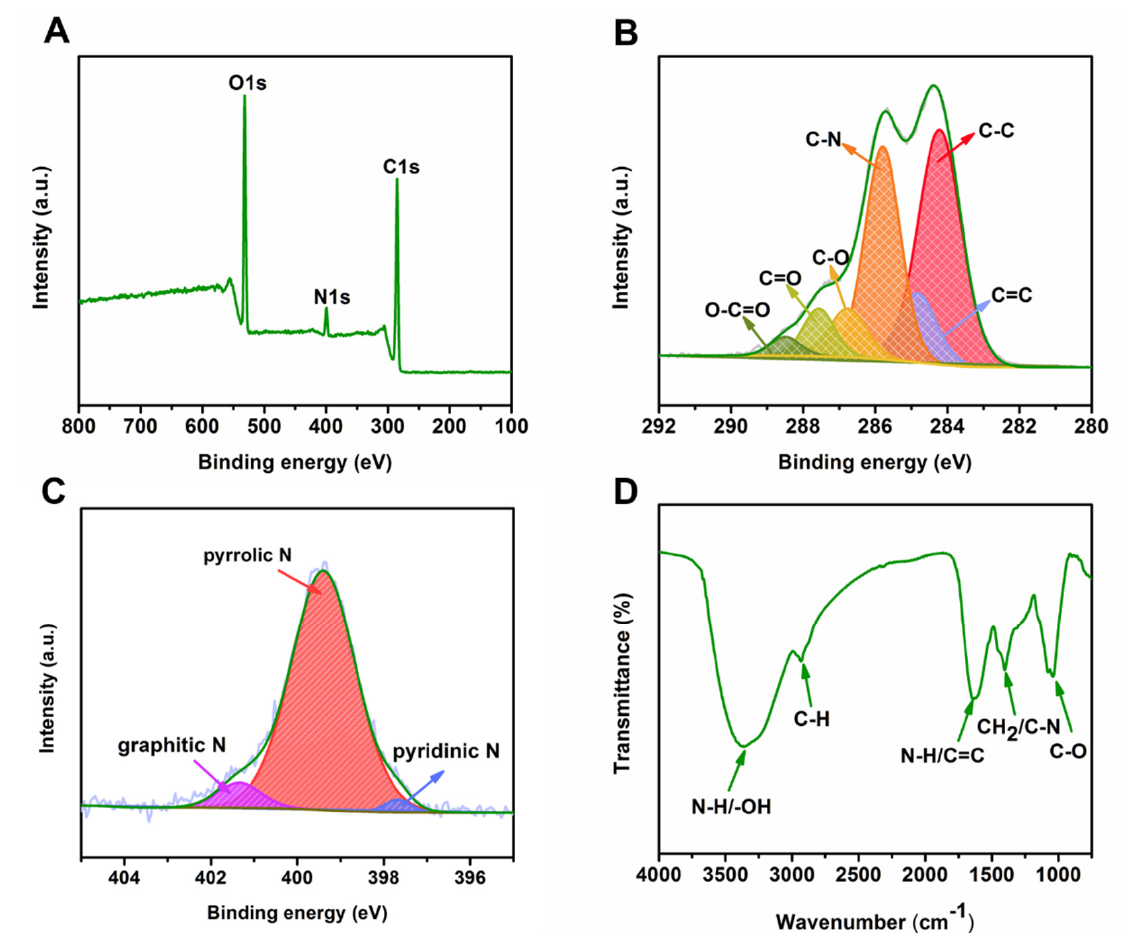
Figure 2. ( A ) XPS survey spectrum of NCDs. High − resolution spectra C1s ( B ) and N1s ( C ) spectra of N − CDs; ( D ) FT − IR spectra of N − CDs.